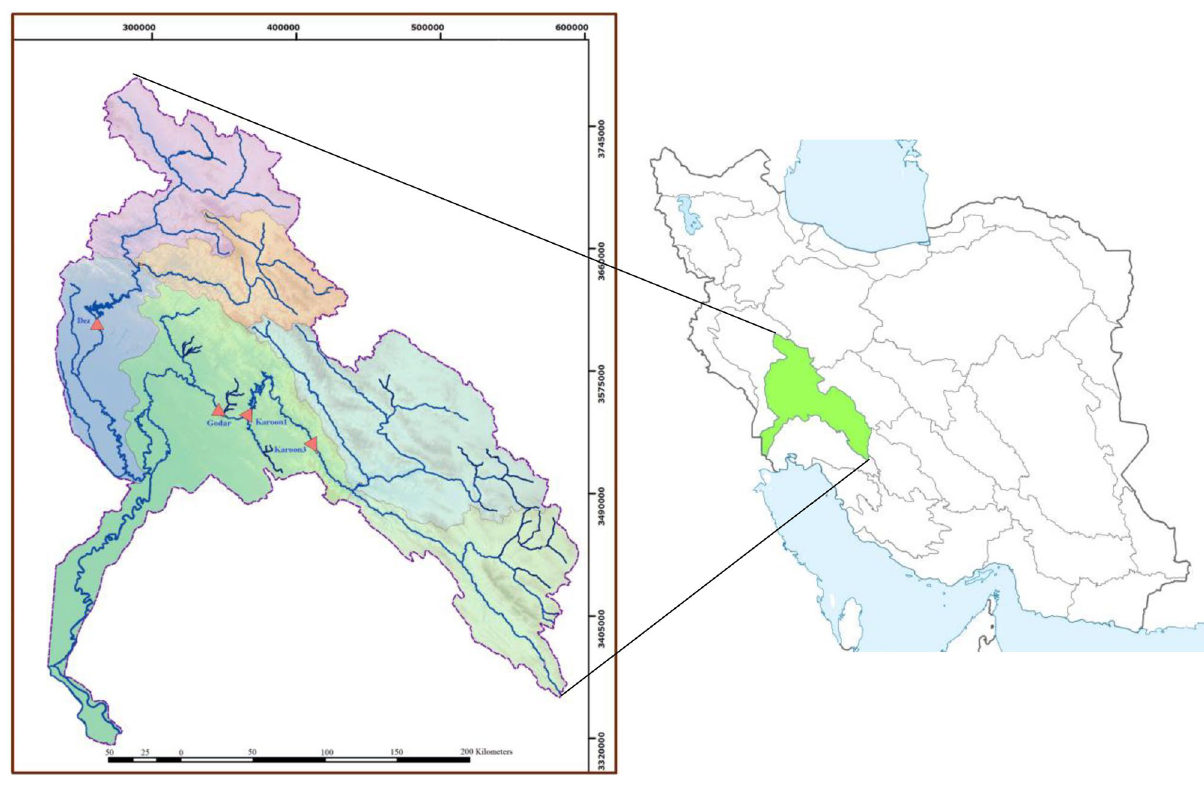
Figure 2. Location of Karoon–Dez